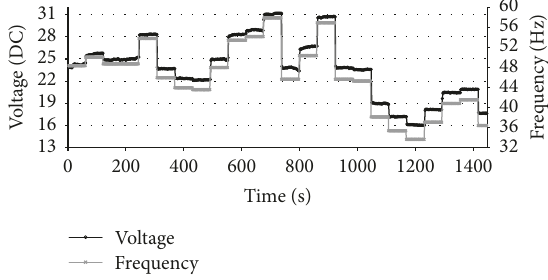
Figure 13: Voltage generation with control